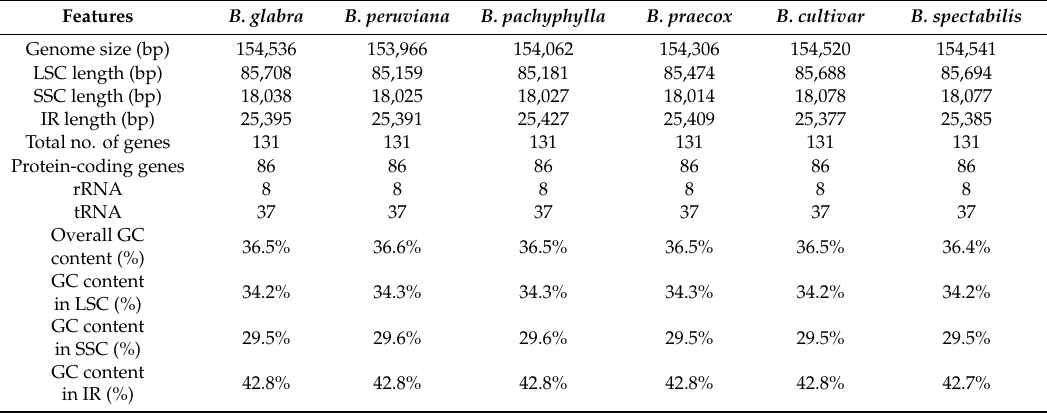
Table 1. Complete chloroplast genome features of five Bougainvillea species and one cultivar.